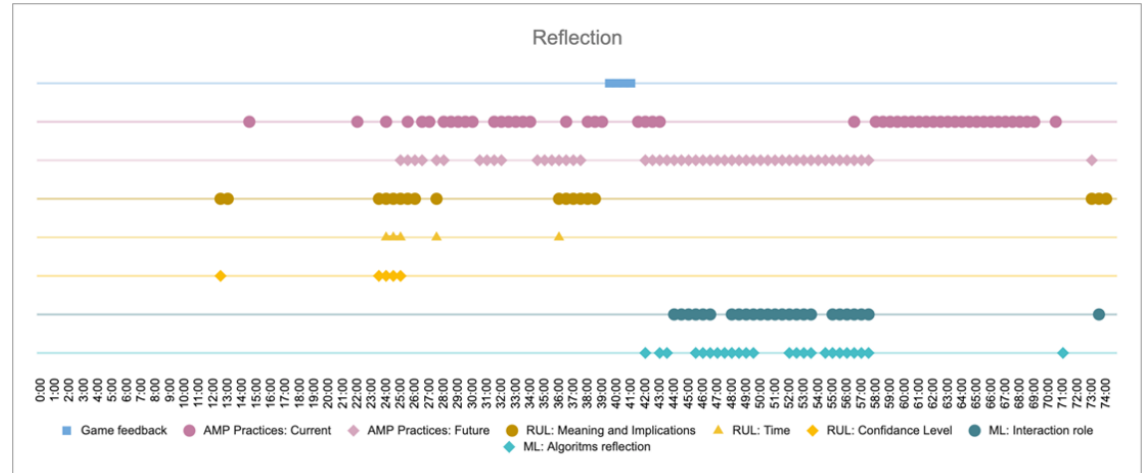
Figure 4. Reflection utterances in participants’ conversation along the